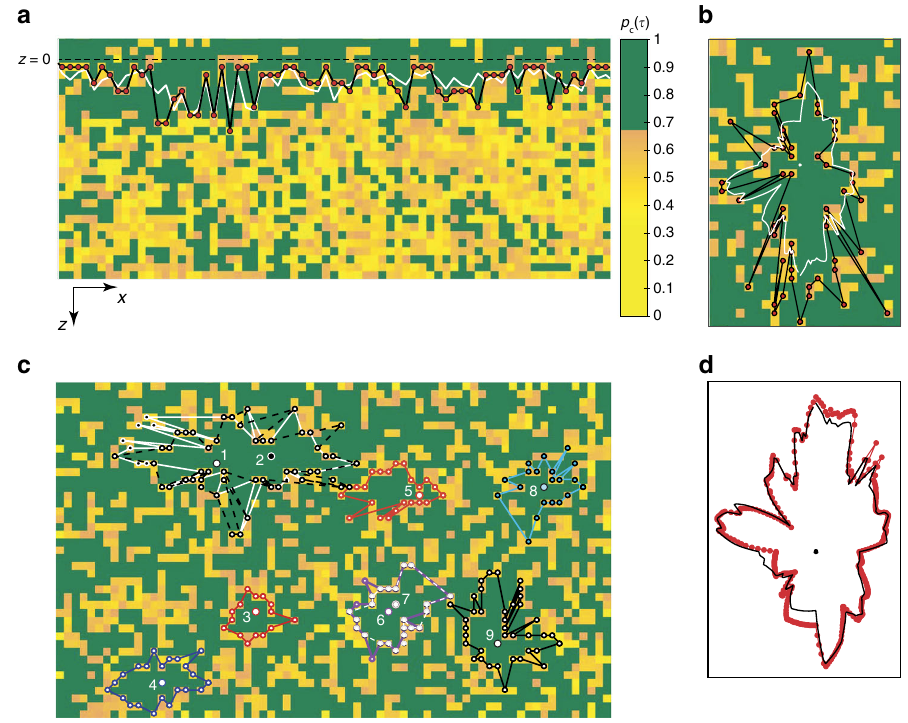
Fig. 3 Identifying amorphous – amorphous interfaces. a The background image represents the p c ( τ α ) for a portion of the fi eld of view containing the amorphous wall located at z ≤ 0 (dashed line) for ϕ = 0.75. The color bar represents p c ( τ α ) values. The black line through the red symbols corresponds to the instantaneous interface pro fi le h ( z , t ) and the white line is the time-averaged pro fi le 〈 h ( z , t ) 〉 t . b Interface pro fi le around self-induced pin represented by the white circle. The background color scheme and the lines have the same meaning as in a . c Instantaneous interface pro fi les around distinct self-induced pins (represented by the numbered circles). Pins 1 and 2 and pins 6 and 7 lie within the same mosaic and yield nearly the same interface. d Instantaneous interface pro fi le post fuzzy-grid averaging. The black line represents the 〈 h ( z , t ) 〉 t around the pin (black circle). In b – d , ϕ =